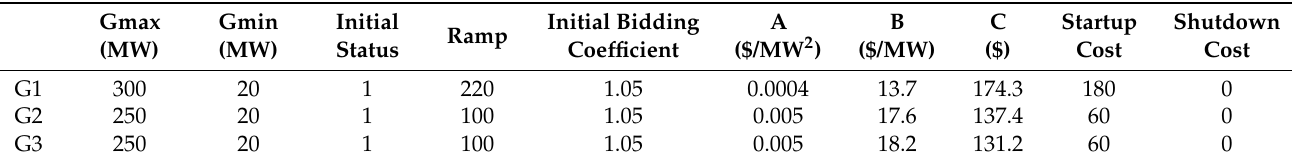
Table A2. Bidding parameters of power producers in the 9-bus